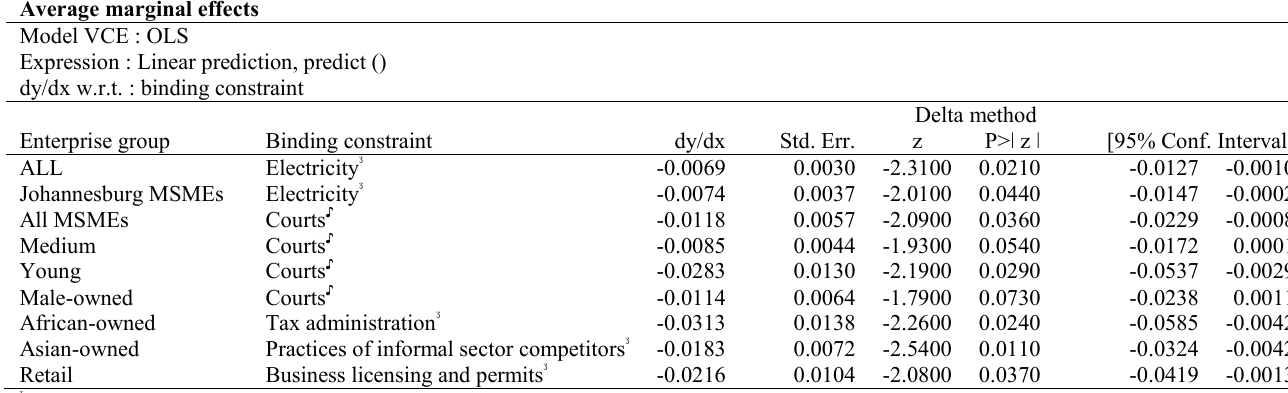
Table 5: Marginal effects of the binding constraints Average marginal effects Model VCE : OLS Expression : Linear prediction, predict